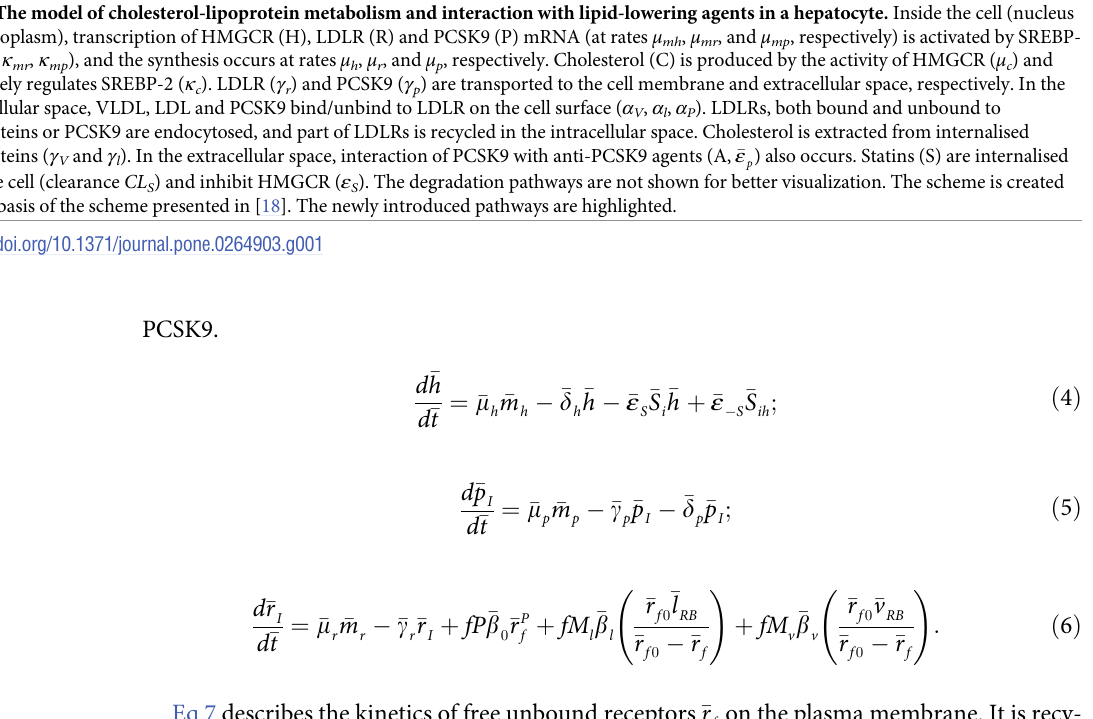
Eq 7 describes the kinetics of free unbound receptors � r on the plasma membrane. It is recy- f cled from the internalized receptor pool, and depleted by internalization and binding with LDL ( � l ), VLDL ( � v ), or PCSK9 ( � p ). The number of receptors associated with a single molecule is accounted with parameters M , M , M . The binding/unbinding rates are determined by α / l v p